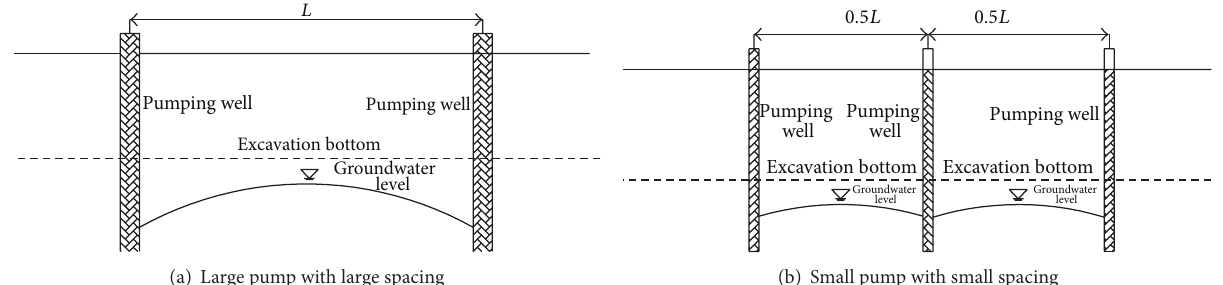
Figure 10: Details of pumping well